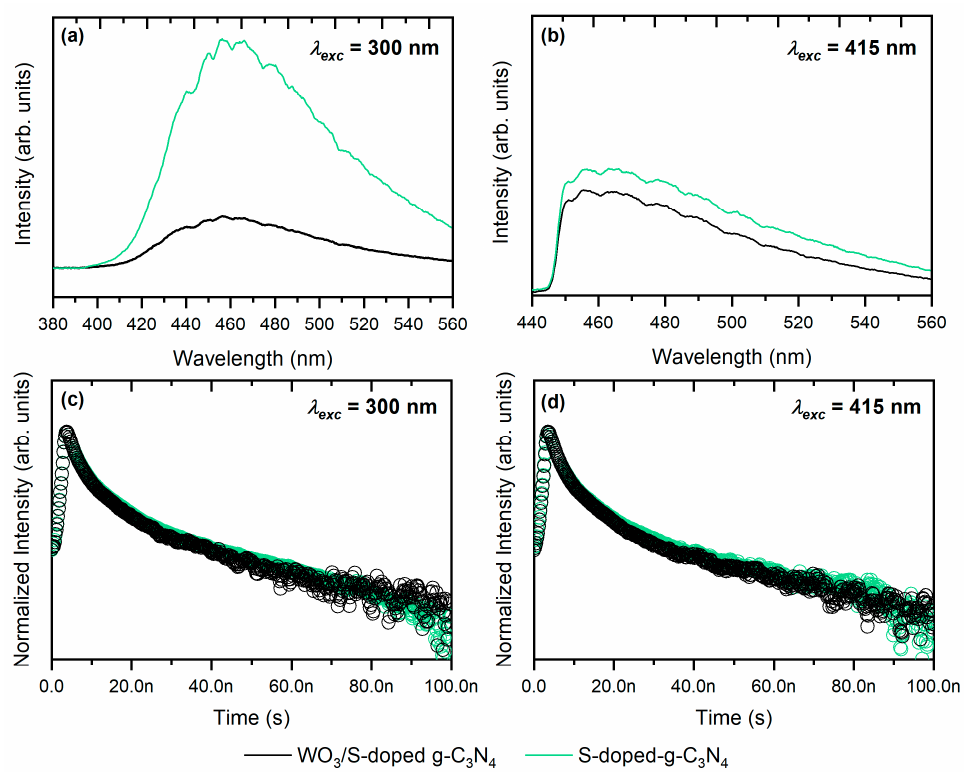
Figure 7. ( a , b ) Photoluminescence spectra and ( c , d ) luminescence decay curves of S-doped g-C 3 N 4 and WO 3 /S-doped g-C 3 N 4 composite under different excitation wavelengths.